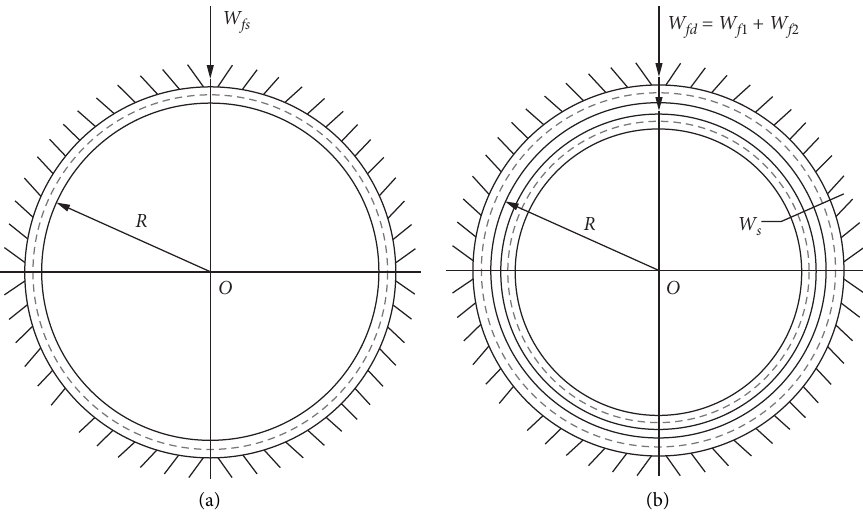
Figure 1: Support structure drawing. (a) Single primary support structure. (b) Double primary support